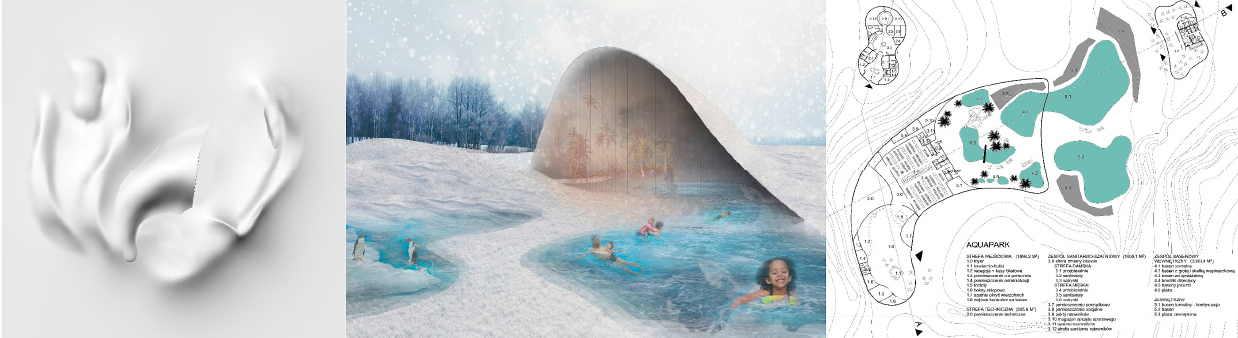
Figure 8. Retention and Recreation: Terrain model by AutoCAD—concept design development (Magdalena Zalewska and Iga Prüffer.